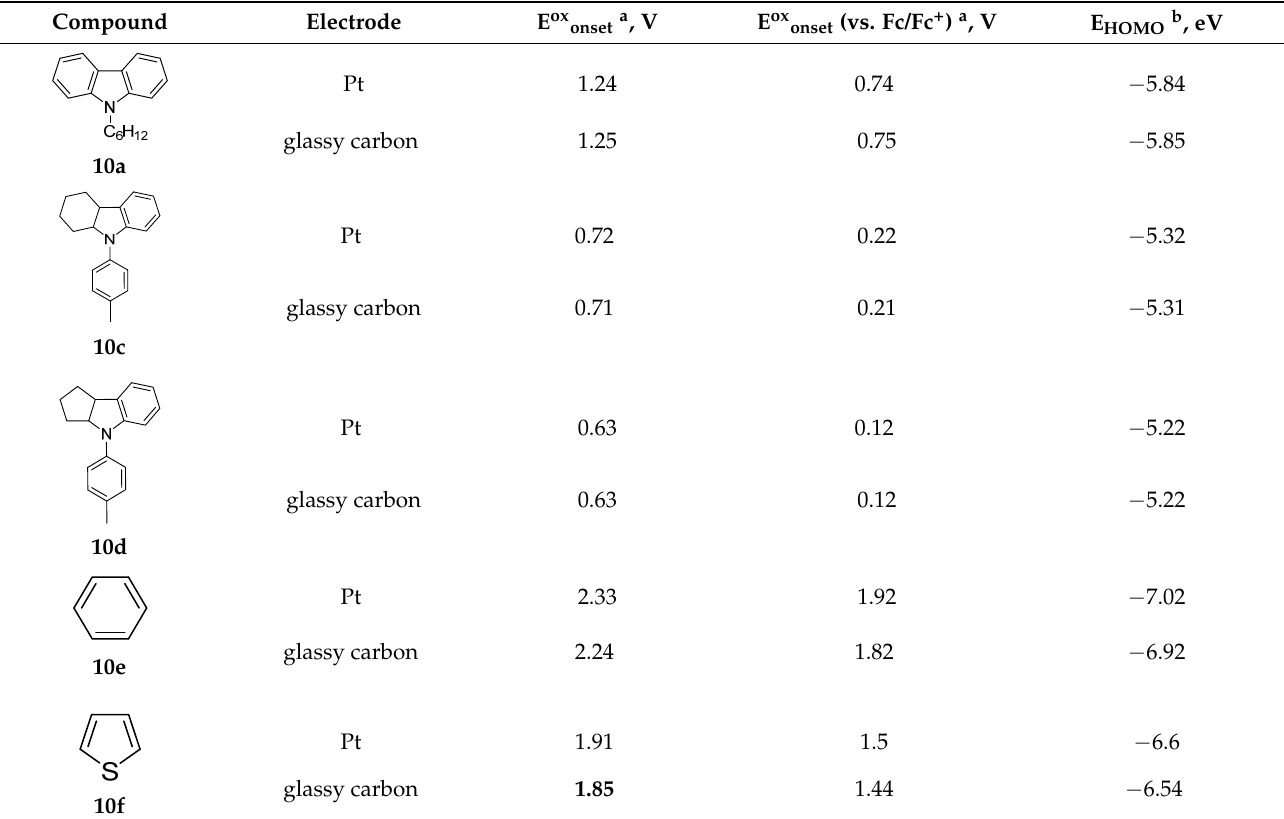
Table 3. Electrochemical properties of donor molecules 10 .